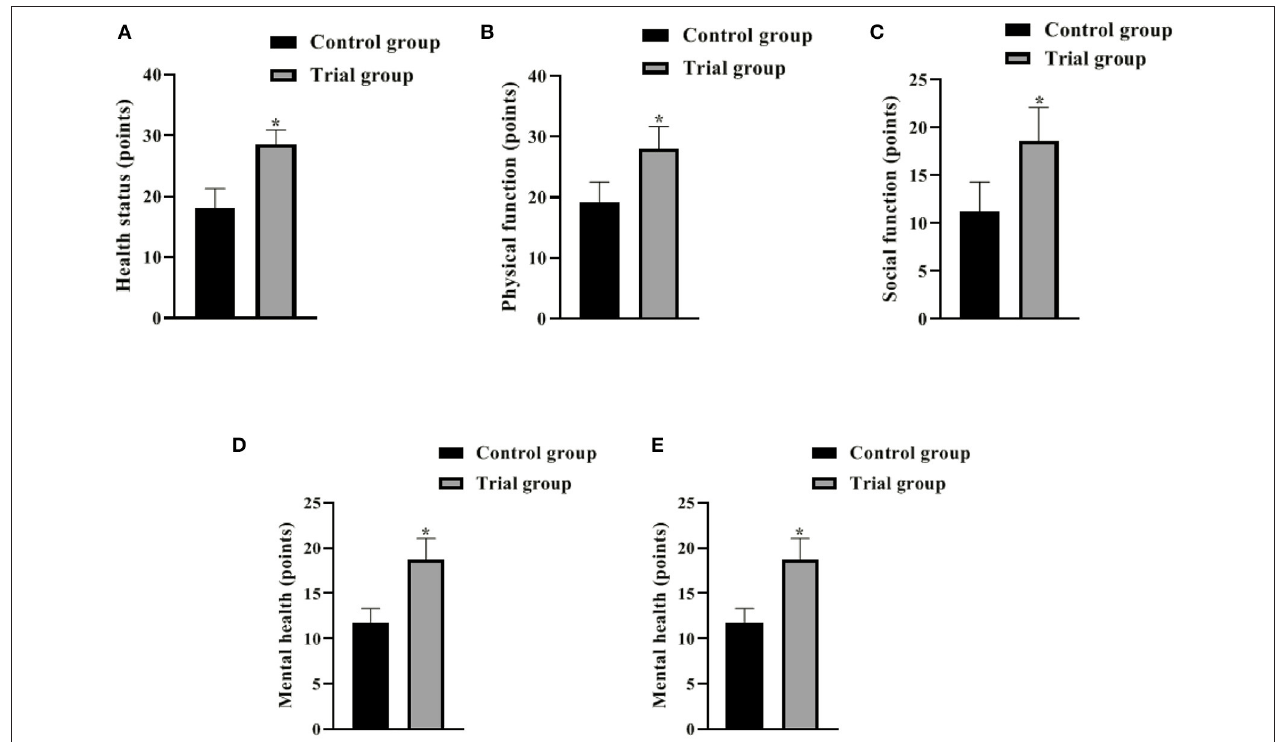
TABLE 2 | Comparison of complications between the 2 groups. Group Hoarseness Choking and